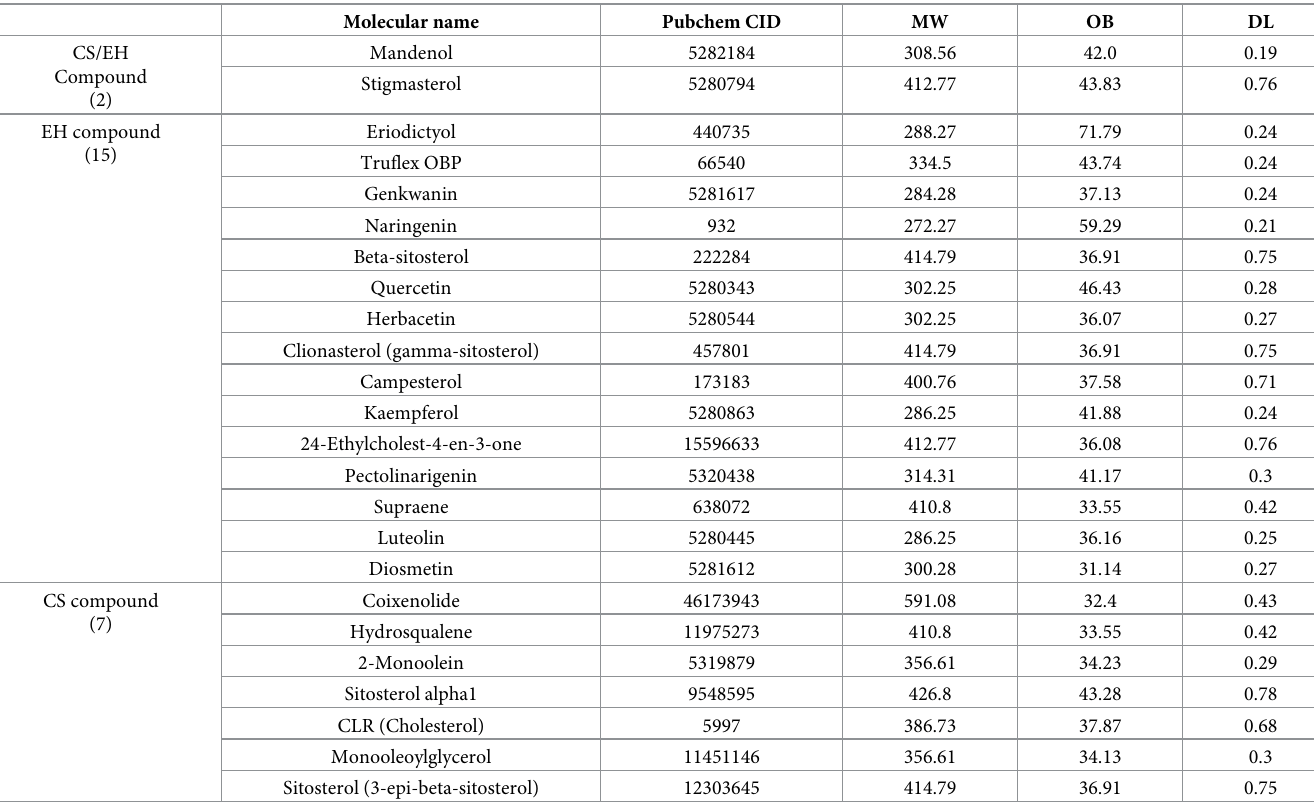
Table 2. List of potential active compounds in Ephedrae herba and Coicis semenSource.